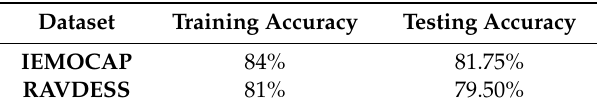
Table 6. Training and testing accuracy of the proposed DSCNN model.